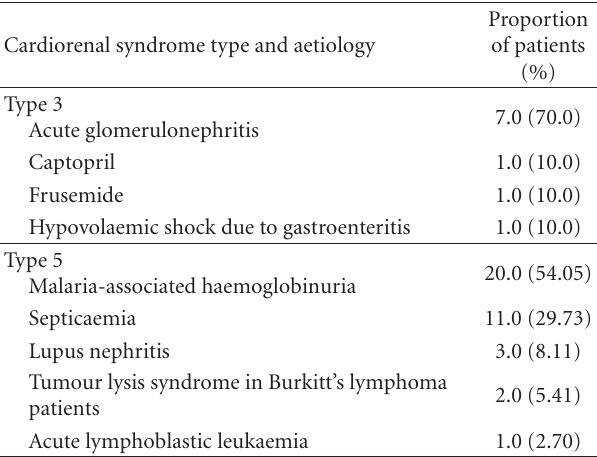
Table 2: Relation between cardiorenal syndrome types and their aetiologies.